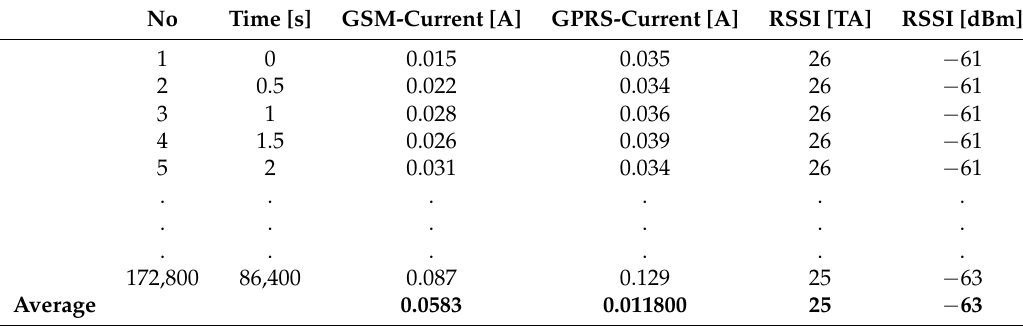
Table 9. Current consumption in location 6, RSSI = − 63